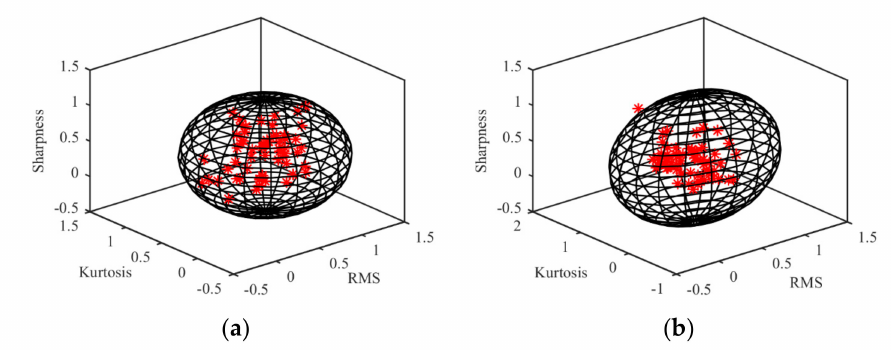
Figure 11. The security domain under normal operating conditions: ( a ) 3000 r / min; ( b ) 4600 r /